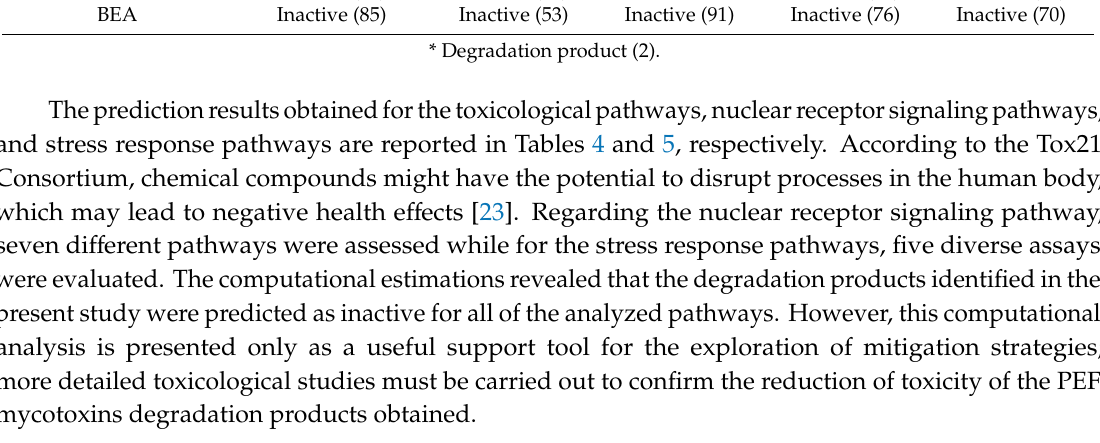
Table 4. Toxicological pathways: Nuclear receptor signaling pathways predicted for detected mycotoxins. Mycotoxin (Degradation